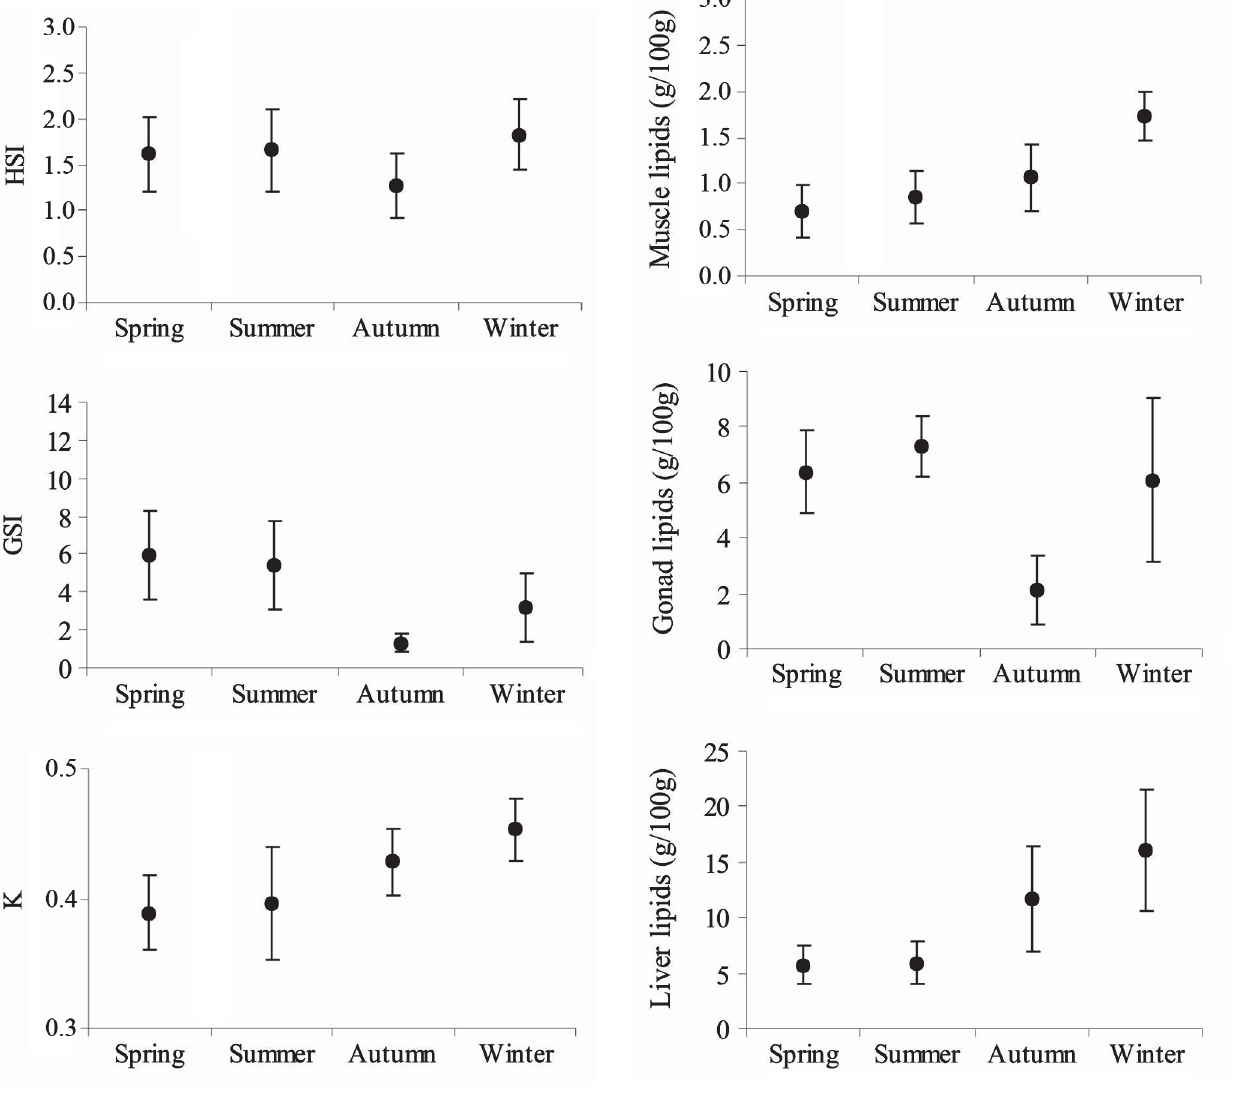
Fig. 1. Seasonal variation of mean and standard deviation of hepatosomatic index (HSI), gonadosomatic index (GSI) and condition index (K) estimated for Percophis brasiliensis .